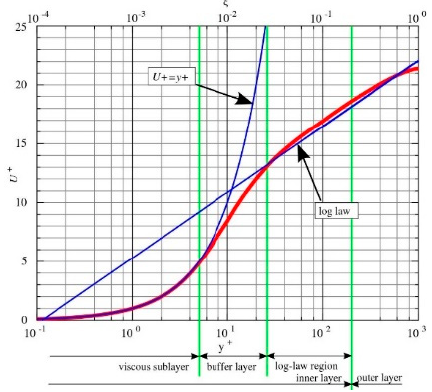
Figure 3. Boundary layer wall ratio.